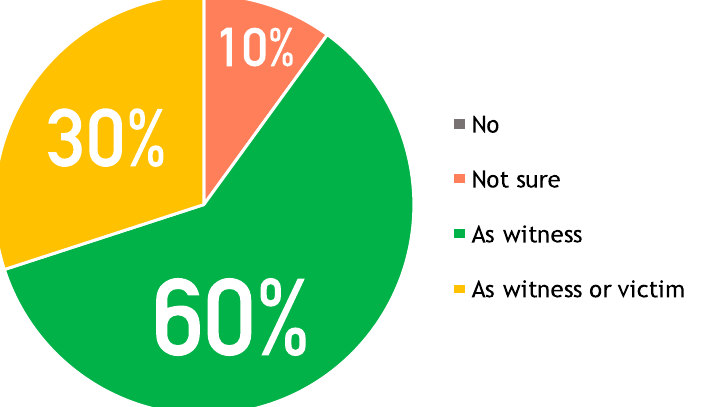
Figure 2. Overall user acceptance (would you use it?) of the proposed mobile application from the usability test.